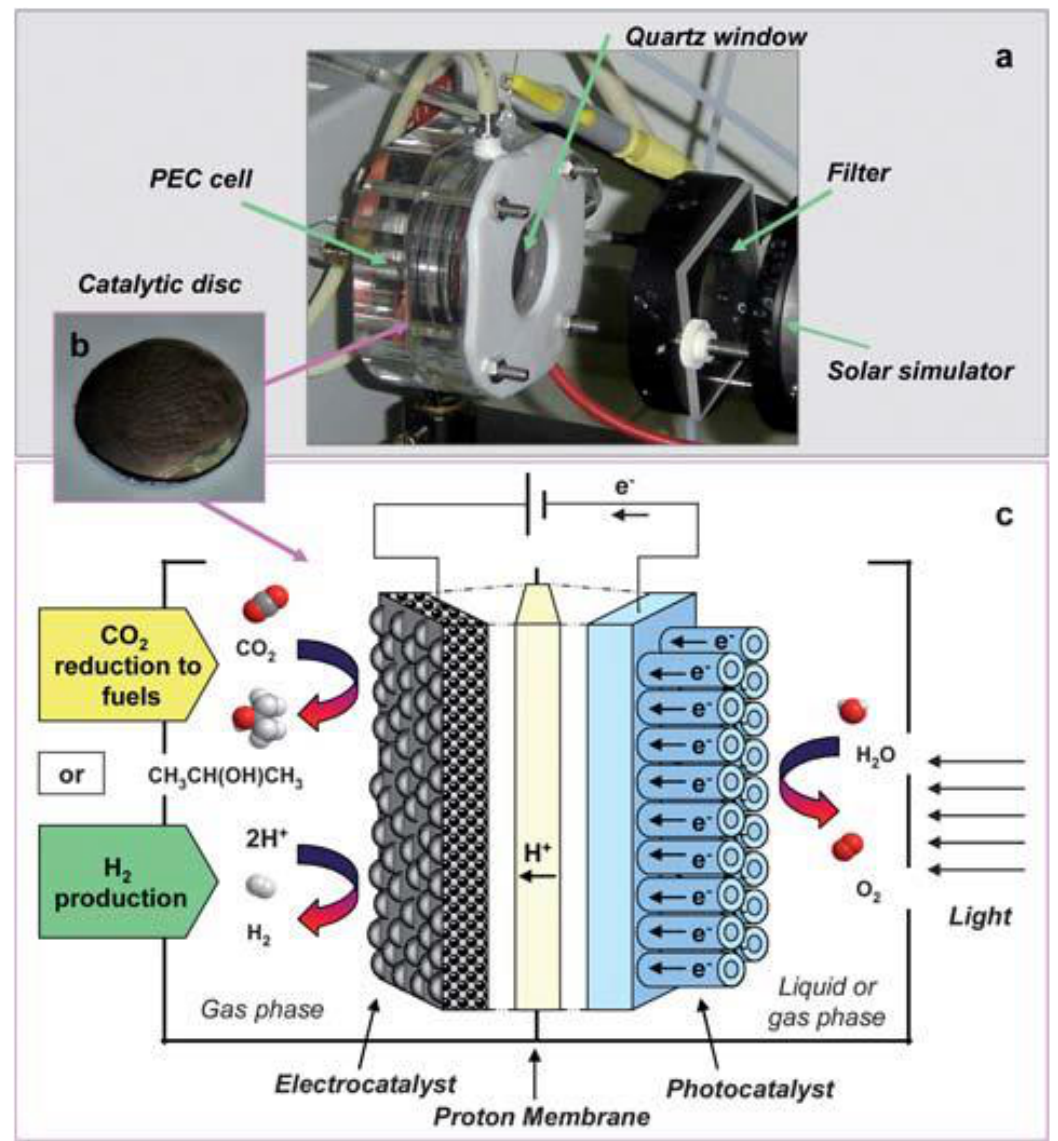
Figure 16. ( a ) View of the lab-scale PEC device. ( b ) Image of the photo/electrocatalytic disc. ( c ) Scheme of the PEC device for CO 2 reduction to fuels and H 2 production. Reprinted from Ref. [150], copyright (2010), with permission from the Royal Society of Chemistry.